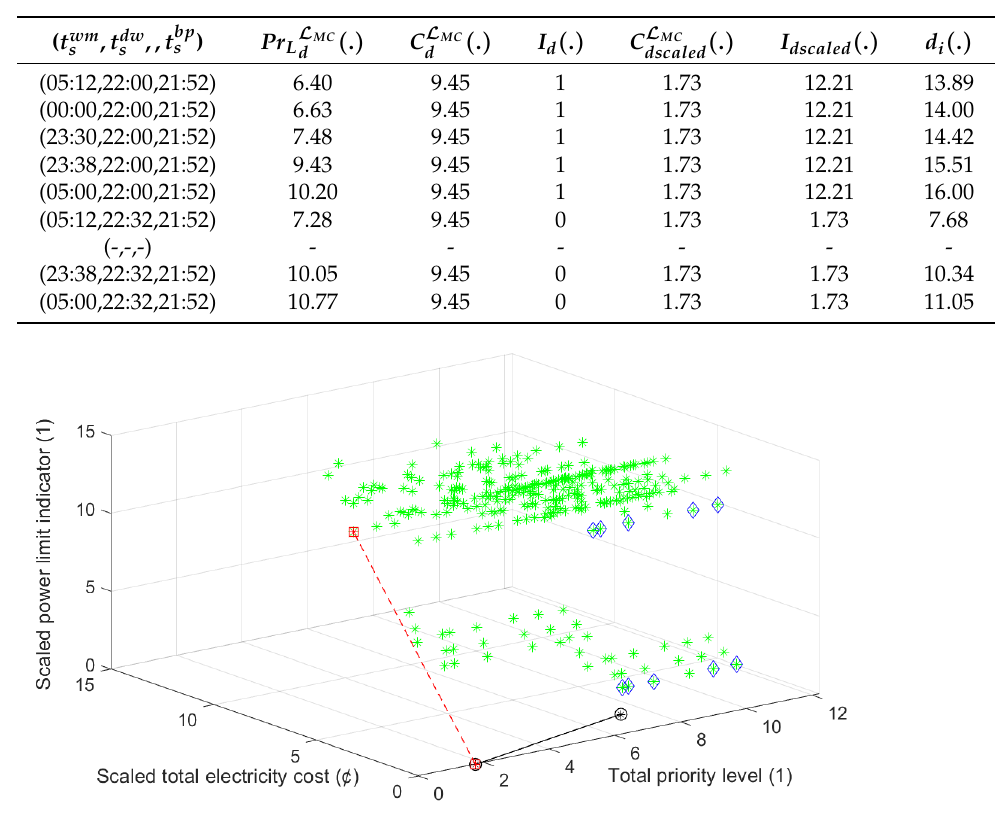
Table 8. For the triplets of starting times with the minimum cost; priority level, electricity cost, power limit indicator, scaled priority level, scaled power limit indicator values and the corresponding values of objective function of BFCP Algorithm 2 for Scenario 1.